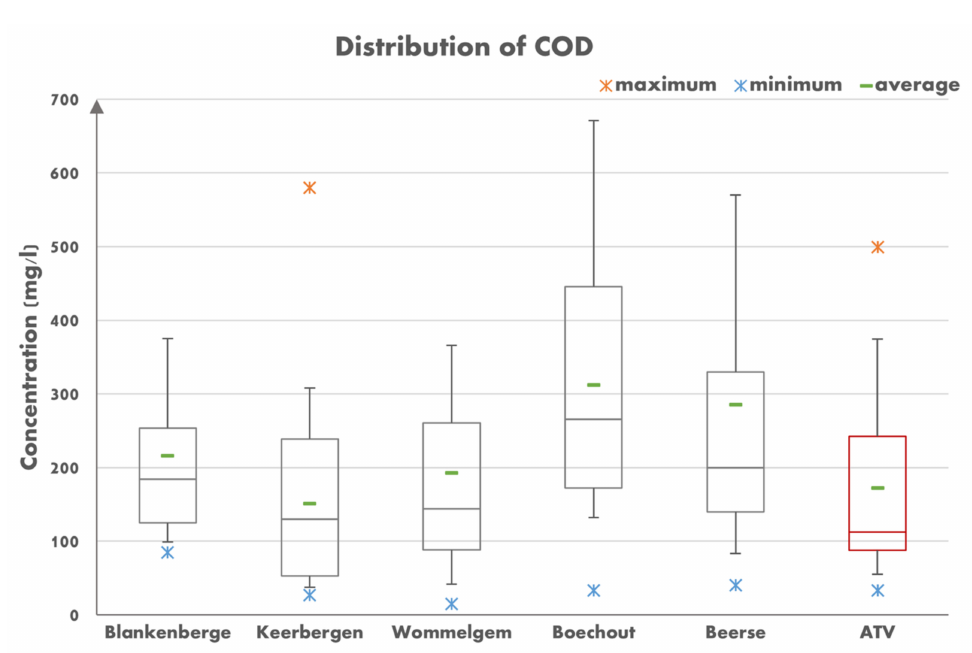
Figure 3. Statistical spread of COD concentrations (1400+ samples) in 5 Flemish catchments + DWA (formerly called ATV)